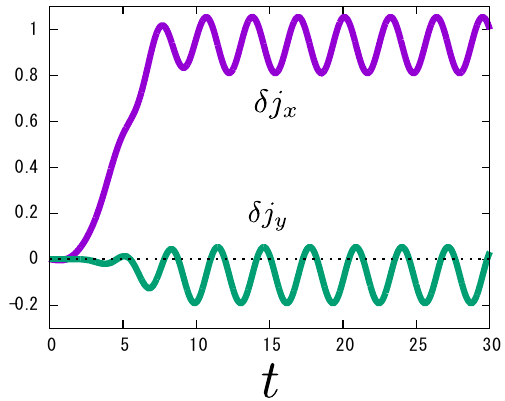
Figure 6. Time dependence of the electric currents for E = 0 : 498, (cid:10) = 1, (cid:1) t = 10 and ~" f = (1 ;